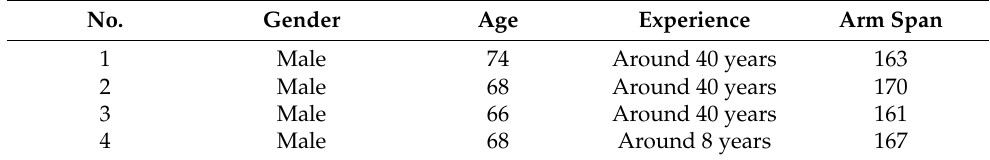
Table 3. Details of subjects in the experiment.